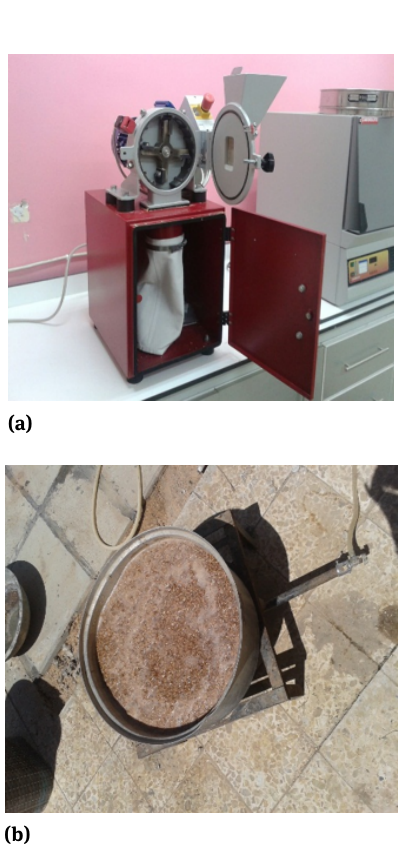
Figure 1: (a) Hummer mill for sawdust manufacture and (b) Sawdust